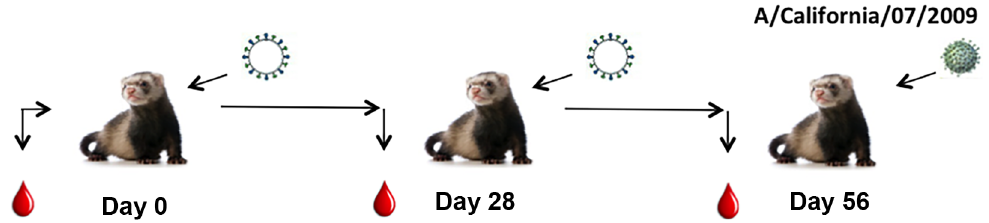
Fig 1. Schematic of IIV vaccination of naive ferrets. Ferrets (n = 8) were vaccinated with IIV vaccine at day 0 and again at day 28. Blood was collected prior to initial infection and at days 28 and 56 post-vaccination . At day 56, the ferrets were challenged with either A/California/07/2009 (H1N1) virus (5x10 4 PFU) or A/Wisconsin/67/2005 (H3N2) virus (1x10 7 PFU) and monitored for morbidity and mortality for 14 days post-infection. Nasal washes were collected at days 0, 1, 3, 5, and 7 to assess viral titers.